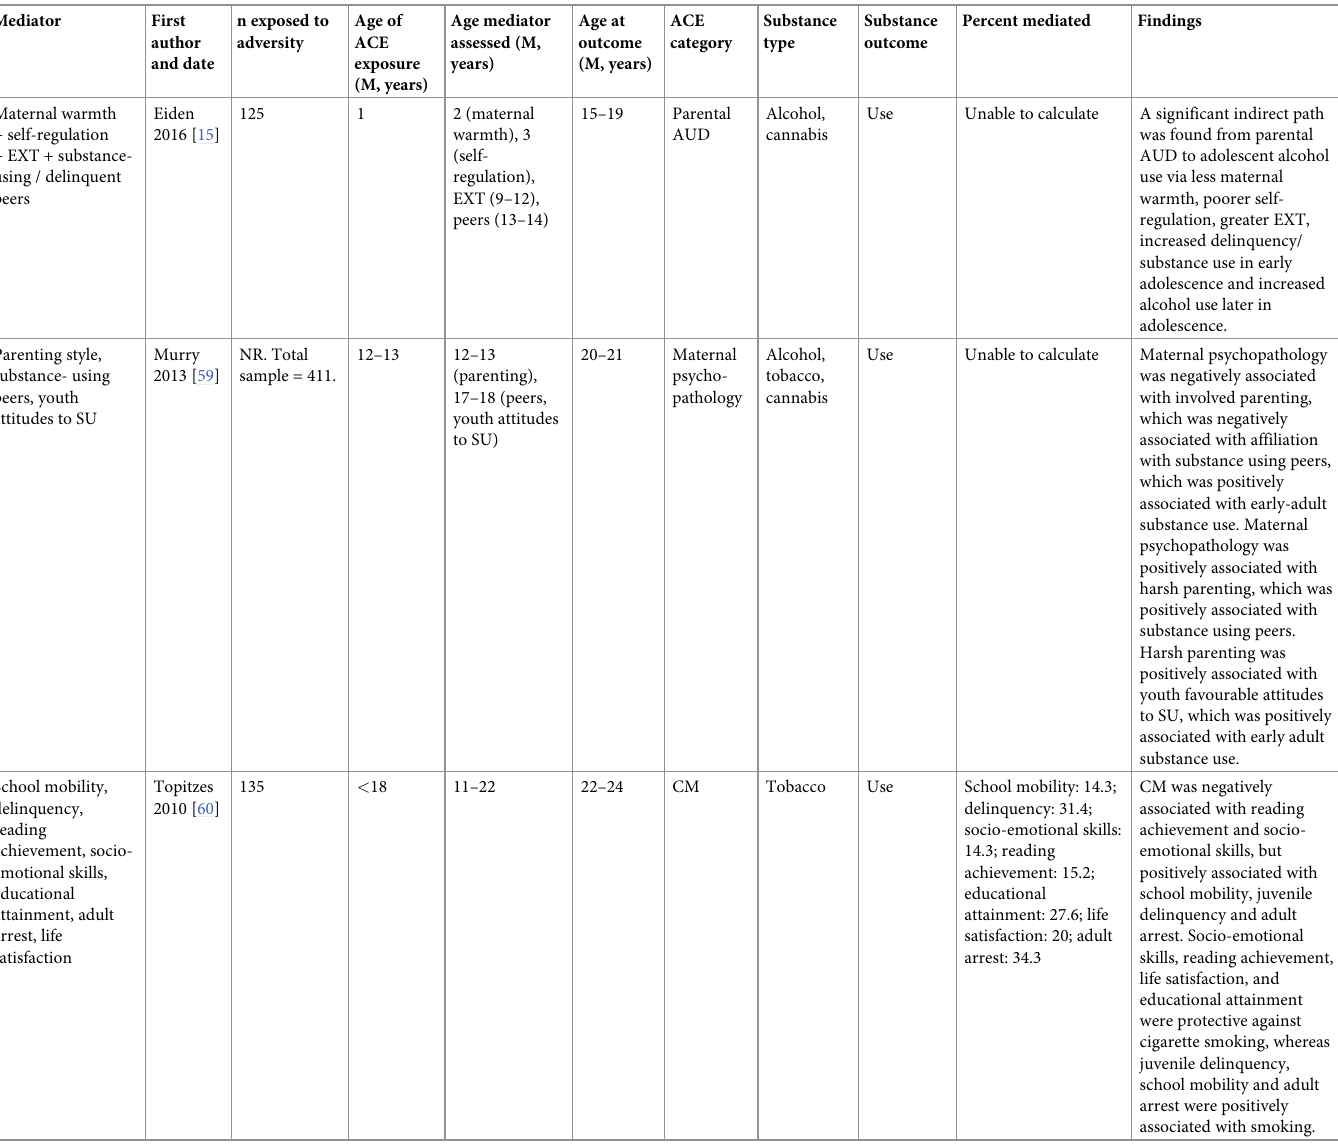
Table 4. Results of three primary studies examining multiple mediators across individual, interpersonal and community levels of